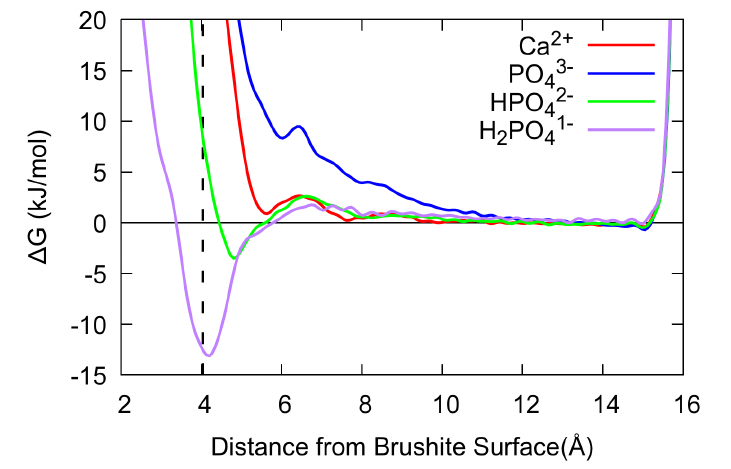
Figure 7. Free energies of adsorption of Ca 2 + , PO 3 − interface with respect to the distance of Ca/P, as applicable, from the central surface calcium. Curves are aligned to ∆ G = 0 in the long-range limit prior to the constraining wall. The location of the second water layer in the experimental spectrum is indicated with a dashed line at a height above the surface of 4.04